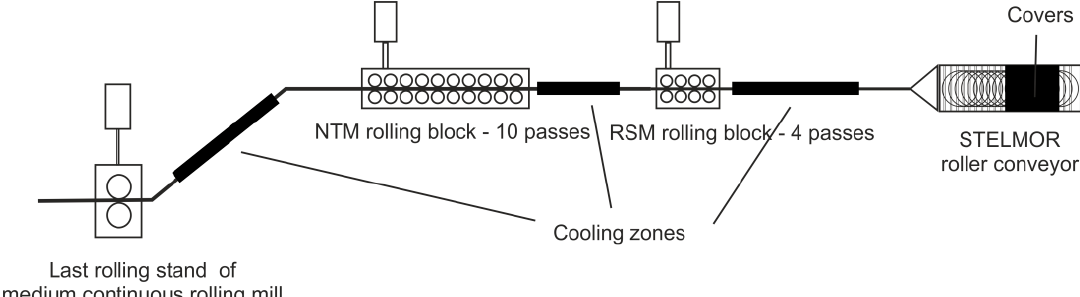
Figure 1. General scheme of the analyzed combined-type rolling mill [17]. In order to obtain a finished product with an even fine-grained ferritic–perlithic microstructure without a clear band structure, the final stage of deformation should take place in the austenitic range, when its temperature is 30–80 °C higher than the initial temperature of the austenite transformation, Ar 3 [31–35]. For 20MnB4 steel, the Ar 3 temperature is 780 °C. In the case of low ‐ carbon and low ‐ alloy steels, which are intended for further cold plastic processing, the most advantageous temperature for forming coils is a temperature of about 850–900 °C. Such a method of laying the coils provides an increased plasticity of the metal, beneficial for the cold drawing process, and allows a decrease in the recrystallizing annealing time after the drawing process [32].